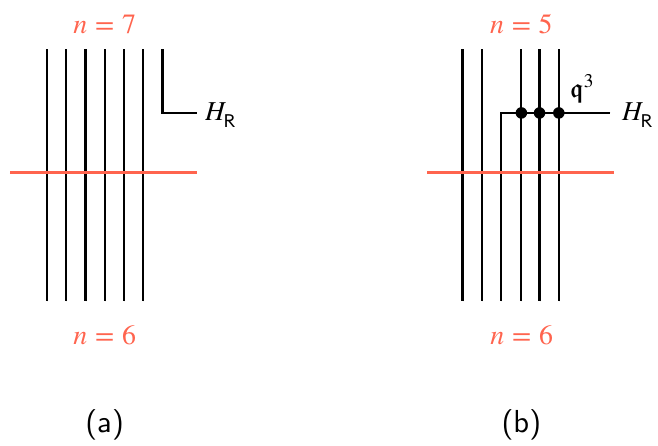
Figure 3 . Two processes that can happen when we act with H R . In (a) an extra chord is added. In (b) a chord is removed. It crosses 3 chords giving a factor of q 3 . We could have also consider the action of H L . The same processes happen but we would draw the insertion on the